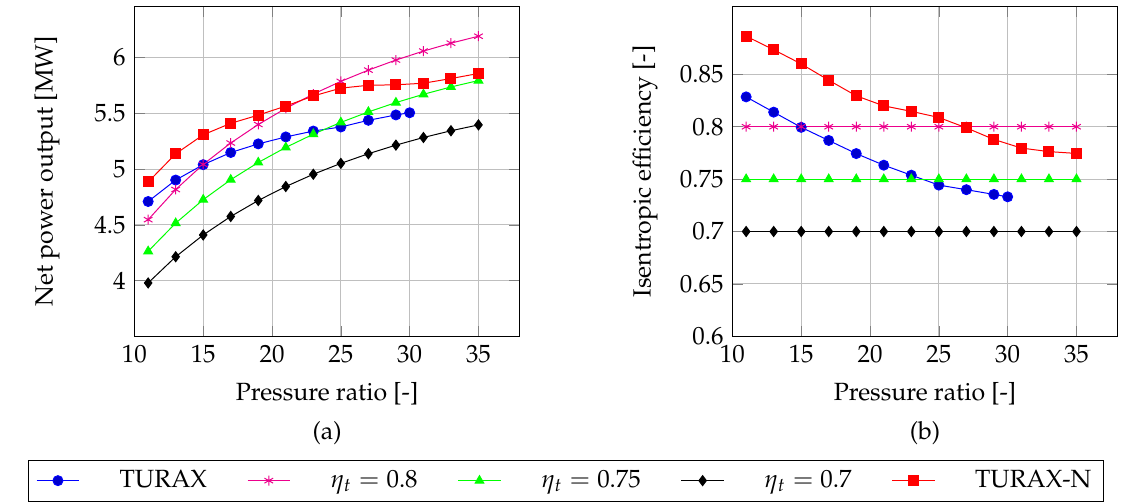
Figure 16. ( a ) net power output versus pressure ratio and ( b ) total-to-total turbine isentropic efficiency versus pressure ratio for an ORC unit utilizing exhaust gas heat from one gas